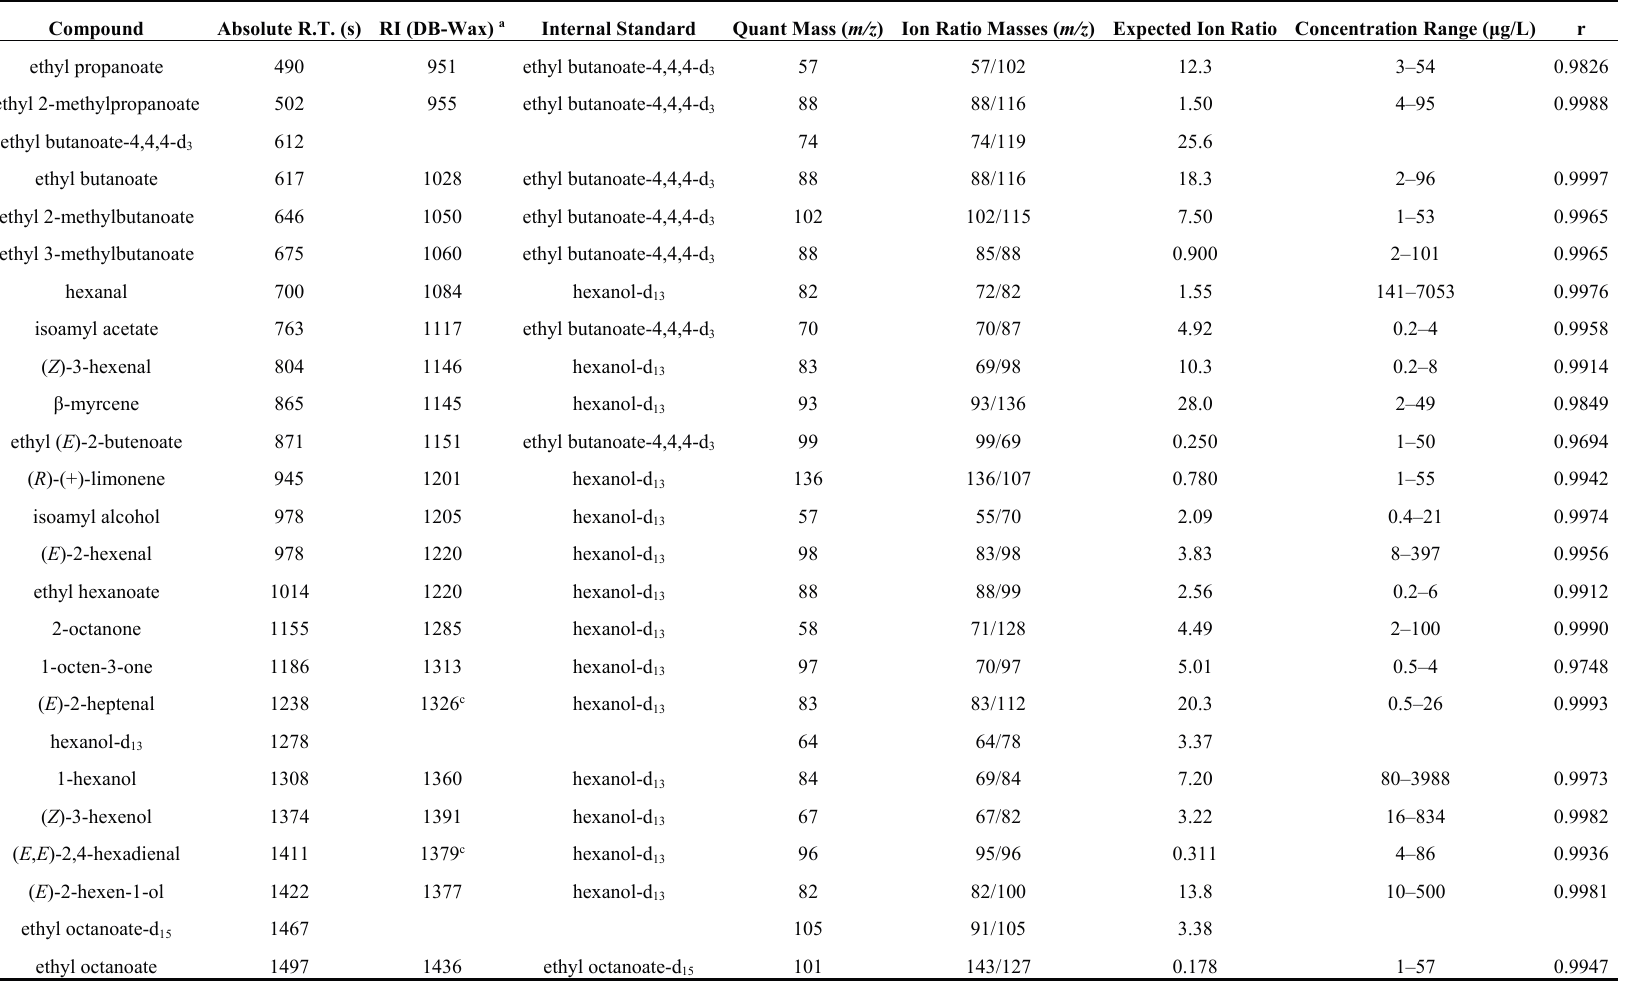
Table 6. Calibration parameters (Retention times (RT), Retention indices (RI), Internal standards, Quantitation masses ( m/z ), Ion ratio masses, Expected ion ratios ( m/z ), Concentration ranges (in μ g/L, unless otherwise noted), and Linear regression coefficients (r) for the analysis of volatile compounds in grape juice and berry skin, using